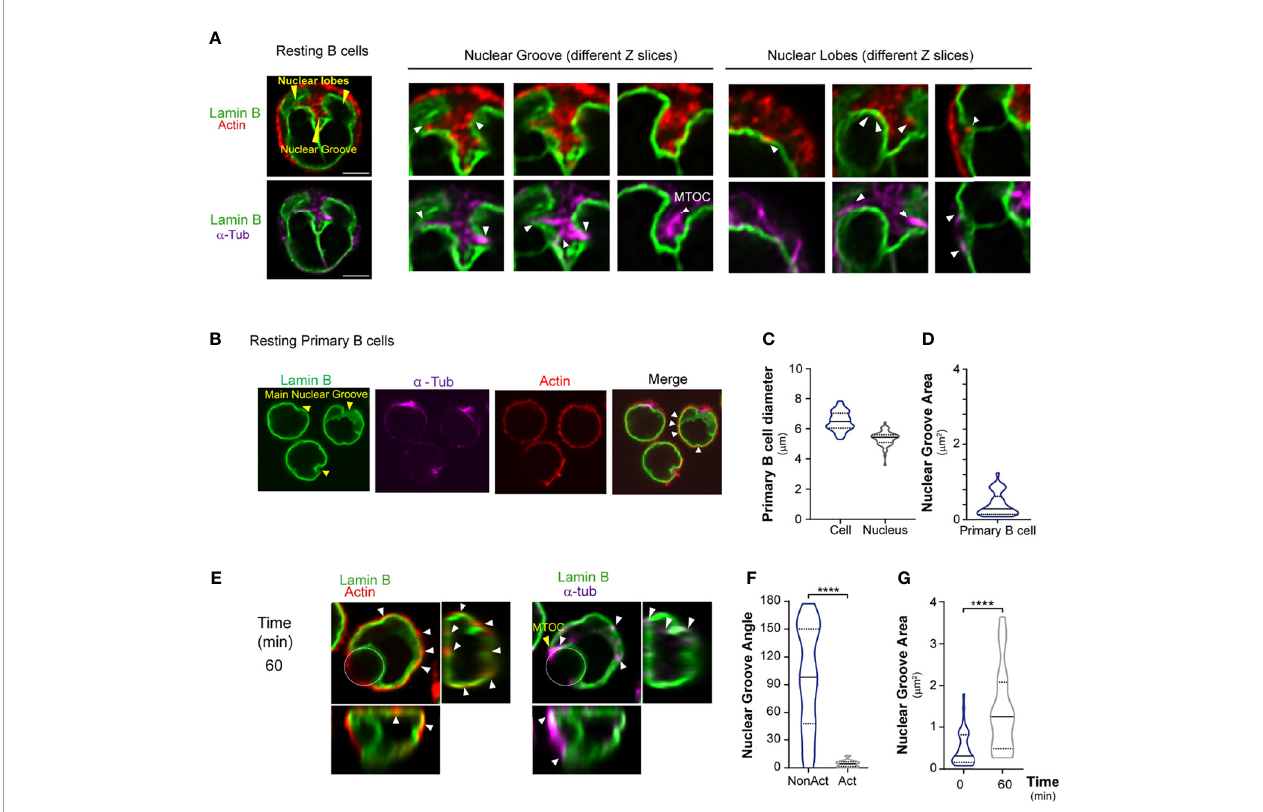
FIGURE 2 | Nuclear shape is regulated by cytoskeleton stability. (A) Confocal images showing actin cytoskeleton (phalloidin, red) and microtubules ( a -tubulin, magenta) strongly associated with the nucleus (Lamin B, green) in resting B cells. Arrowheads: nuclear groove; lobes: yellow; connection between cytoskeleton and nucleus: white. Scale bar 5 µm. (B) Representative confocal images of resting mouse primary B cells; stain colors/arrowheads as indicated as in (A) . Primary B cells with a nucleus that occupies almost the entire area of the cell. (C) Diameter of primary B cells and their nuclei and (D) nuclear groove area. (E) Representative confocal images of primary B cells incubated with antigen-coated beads for 60 min. White circles indicate bead position. Arrowheads: nuclear groove. (F) Nuclear orientation, measured as the angle of the nuclear groove. n>55, unpaired t-tests; ****p < 0.0001. (G) Nuclear groove area upon activation. n>55, Mann-Whitney test; ****p < 0.0001; from three independent